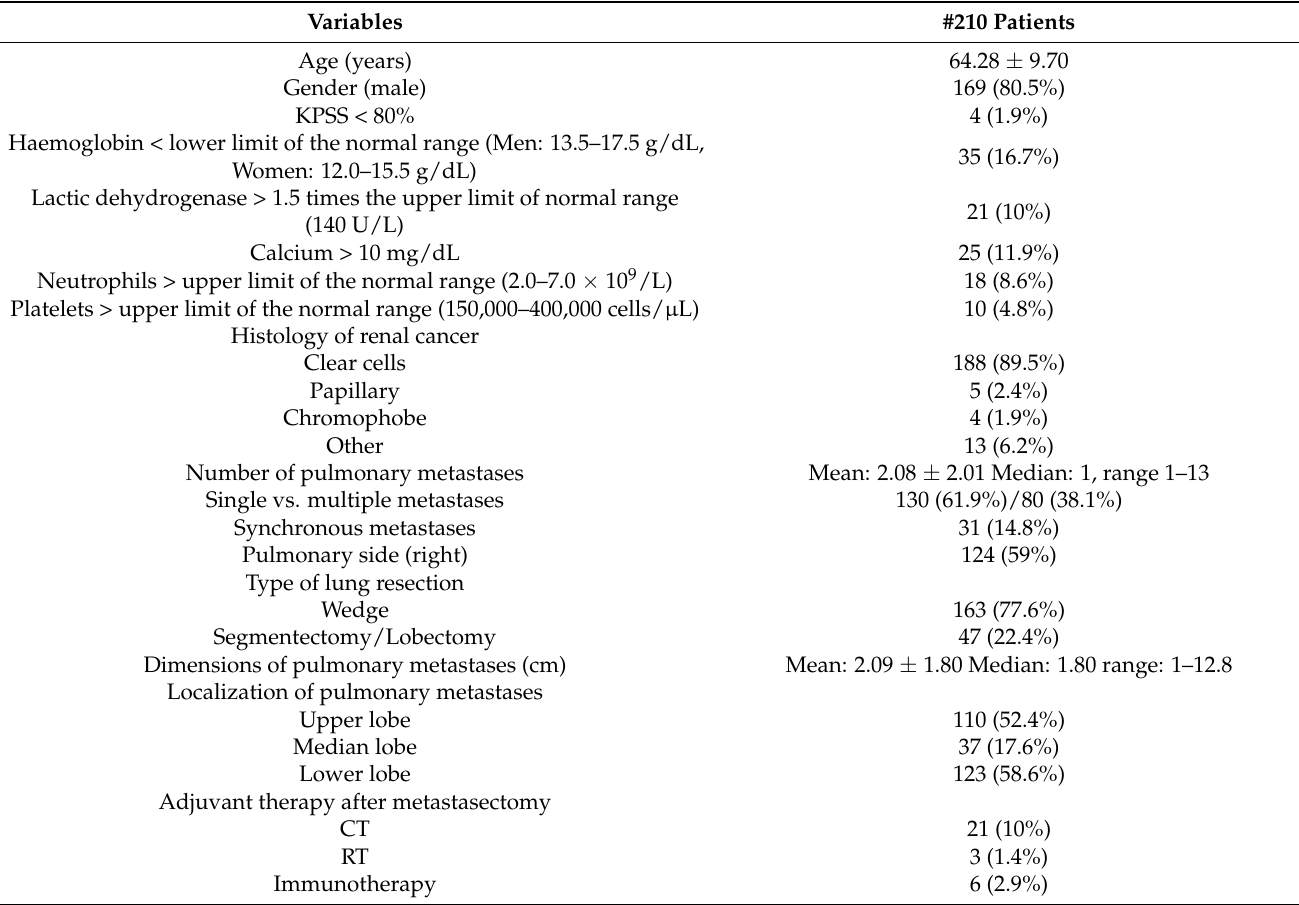
Table 1. Clinicopathological characteristics of the